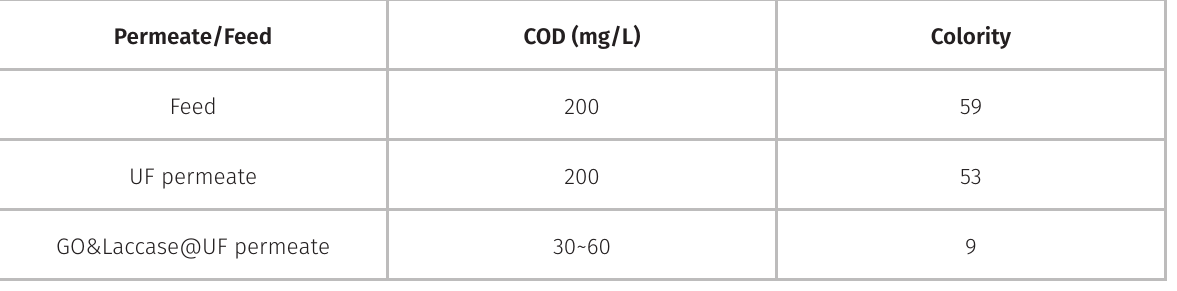
Figure 4. Photos of permeate obtained from filtration with UF (a) and GO&Laccase@UF (b).